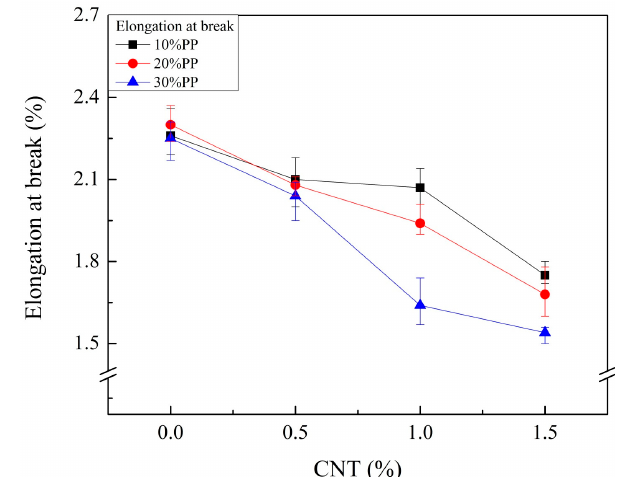
Figure 4. Elongation at break results of CF- and CNT-reinforced PA6/PP composites with different PP and CNT compositions.